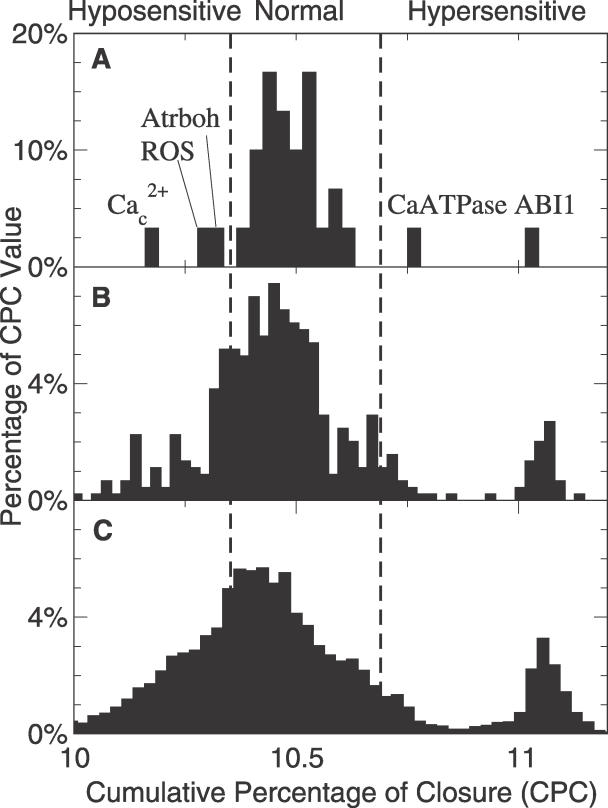
Classification of Close-to-Normal Responses(A) For all the single mutants that ultimately reach 100% closure, we plot the histogram of the cumulative probability of closure (CPC). We find three distinct types of responses: hypersensitivity (CPC > 10.7, for abi1 and Ca2+ ATPase disruption); hyposensitivity (CPC < 10.35, for Ca2+
c , atrboh, and ROS disruption); and normal responses ( 10.35 < CPC < 10.7). For all the double (B) and triple (C) mutants that eventually reach 100% closure at steady state when ABA = 1, we classify the responses using the CPC thresholds defined by the single mutant responses. The CPC threshold values are indicated by dashed vertical lines in the plot.